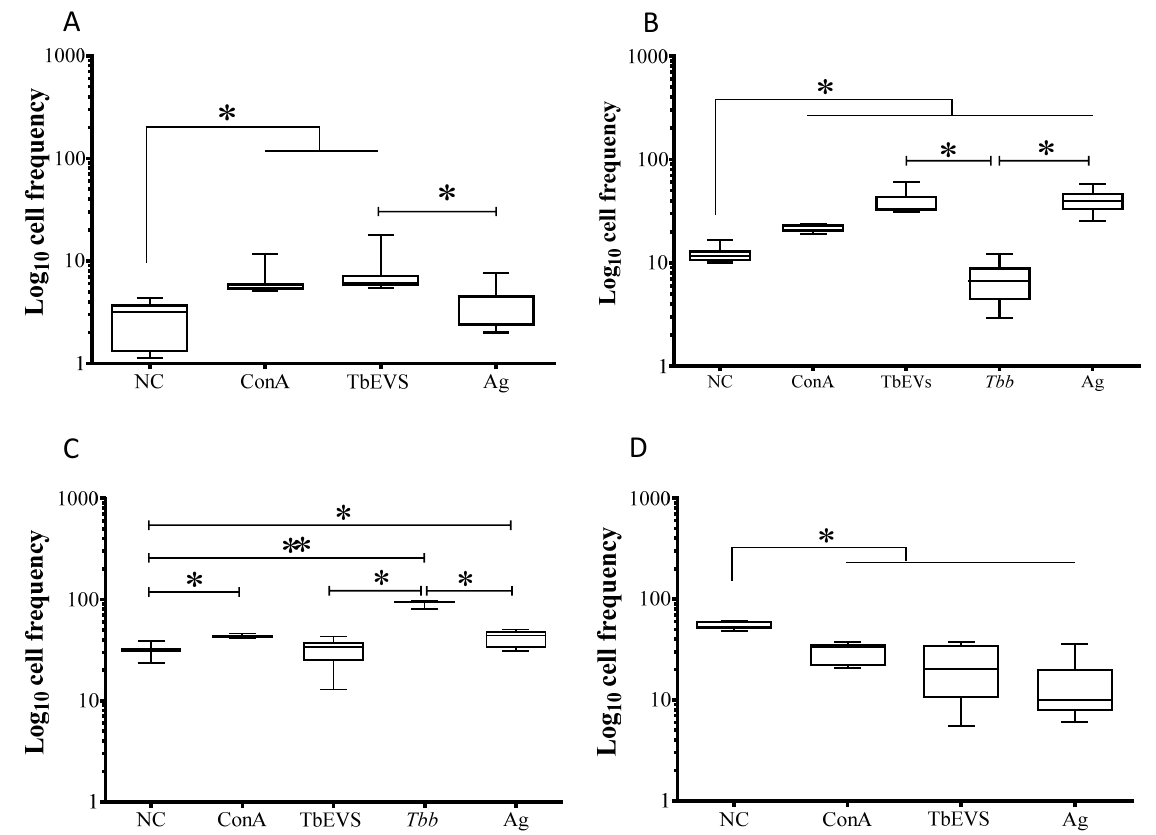
Figure 9. CD25 + and FoxP3 + CD8 + T cell subsets induced by T. b. brucei EVs. Mouse lymphocytes exposed to T. b. brucei parasites ( Tbb ), stimulated by Ag, TbEVs, and ConA, and unprimed cells (negative control, NC) were labelled with CD3, CD25 and FoxP3 monoclonal antibodies and evaluated by flow cytometry. CD3 + cells were gated and the frequency of CD25 + FoxP3 + ( A ), CD25 − FoxP3 − ( B ), CD25 + FoxP3 − ( C ), and CD25 − FoxP3 + ( D ) cell subsets were estimated. In consequence of the low levels of CD3 + cells, the frequency and density of FoxP3 were not considered in T. b. brucei exposed-PBMC. Results of ( n = 6) at least three independent experiments performed in duplicate are represented by whiskers box-plot, median, minimum and maximum values. The non-parametric Wilcoxon matched-pair signed-rank test was used for statistical comparisons. * ( p < 0.05) and ** ( p < 0.01) indicate significant differences.